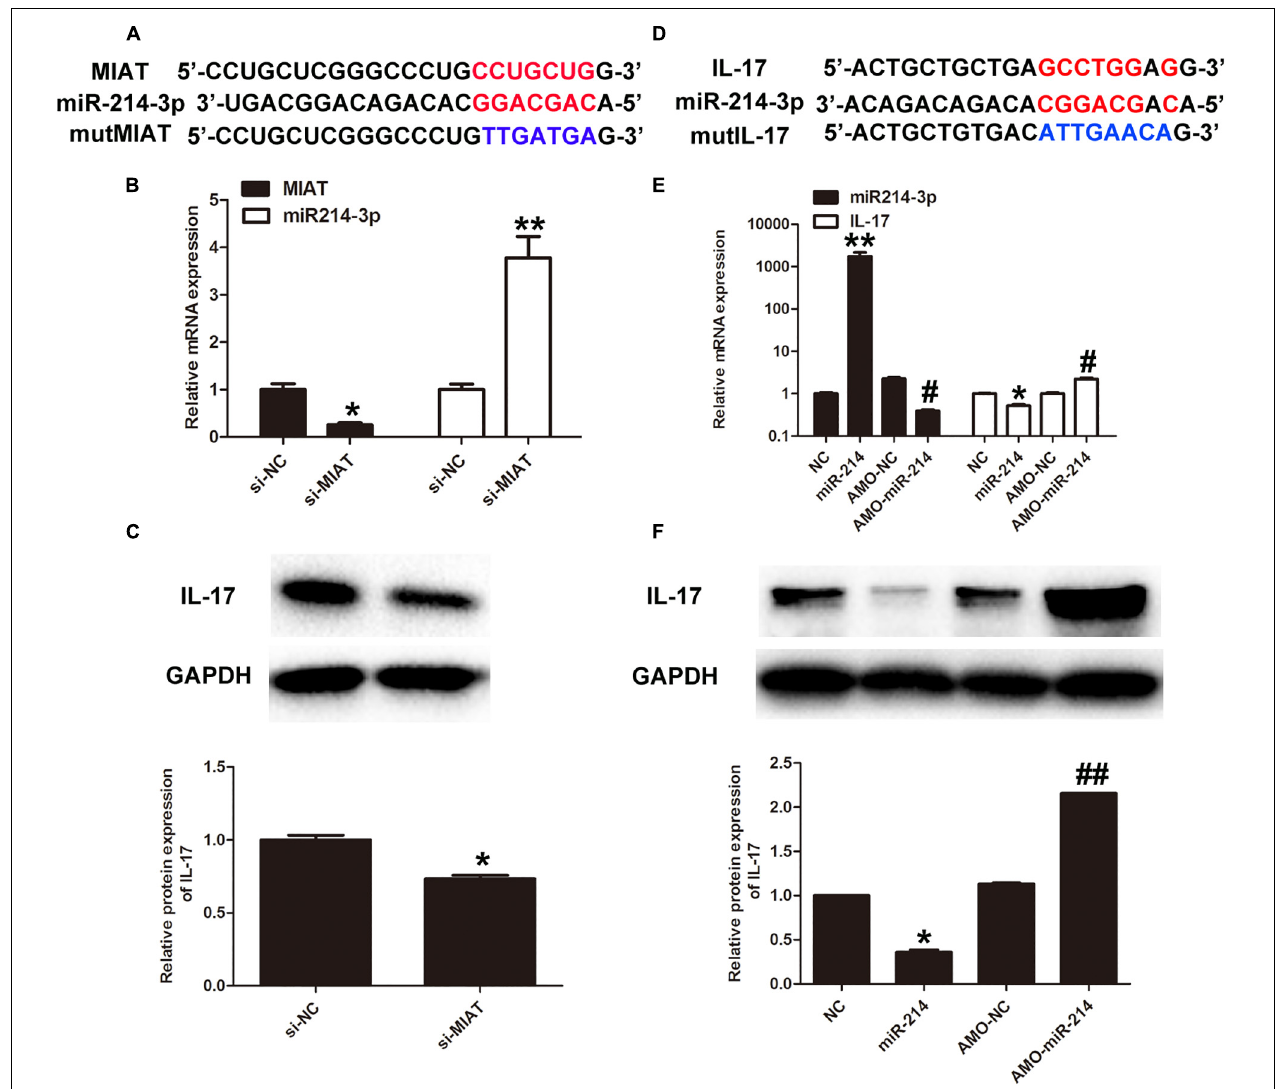
FIGURE 3 | LncRNA-MIAT regulates IL-17 production via miR-214-3p. (A) Bioinformatics prediction using miRcode indicated that MIAT sequence contained the putative binding site of miR-124-3p. (B) Primary cardiomyocytes were either treated with si-NC (20 µ mol/) or si-MIAT (20 µ mol/) for 48 h. The expression levels of MIAT and IL-17 expression were detected in cardiomyocytes under either si-NC or si-MIAT group, ∗ p < 0.05. (C) Cell lysates of primary cardiomyocytes treated with si-NC or si-MIAT were collected and processed for western blotting to examine the protein expression of IL-17 as Figure 2B mentioned, ∗ p < 0.05. (D) IL-17 was predicted as a target gene of miR-124-3p using miRBase. (E) Primary cardiomyocytes were treated with NC, miR-214, AMO-NC and AMO-miR-214, respectively, for 48 h. The corresponding expression levels of miR-214-3p and IL-17 expression were detected in cardiomyocytes by q-RT-PCR, ∗ p < 0.05, ∗∗ p < 0.01 (between NC and miR-214); # p < 0.05 (between AMO-NC and AMO-miR-214). (F) Cell lysates of primary cardiomyocytes treated with NC, miR-214, AMO-NC, and AMO-miR-214, respectively, were collected and processed for western blotting to examine the protein expression of IL-17 as Figure 2B mentioned.